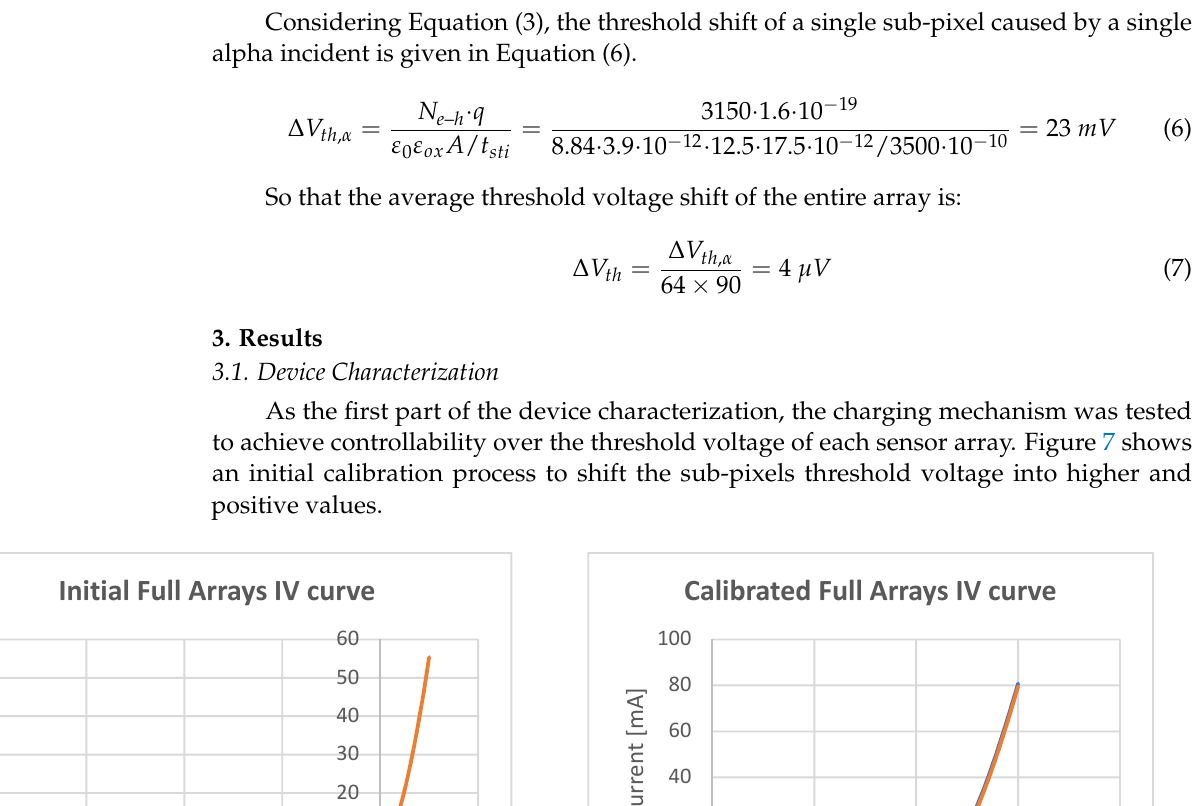
Figure 6. ( a ) Readout schematic as a current subtractor followed by a TIA. ( b ) current subtractor design based on cascaded current mirrors.